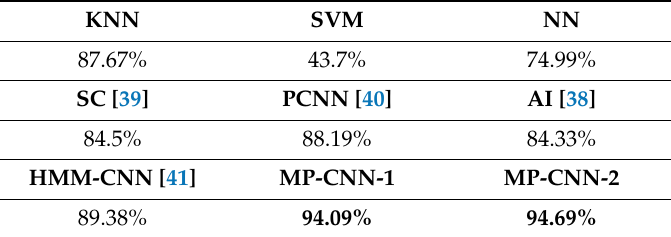
Table 4. Classification accuracy of the Skoda dataset using different methods. We show our result in bold.